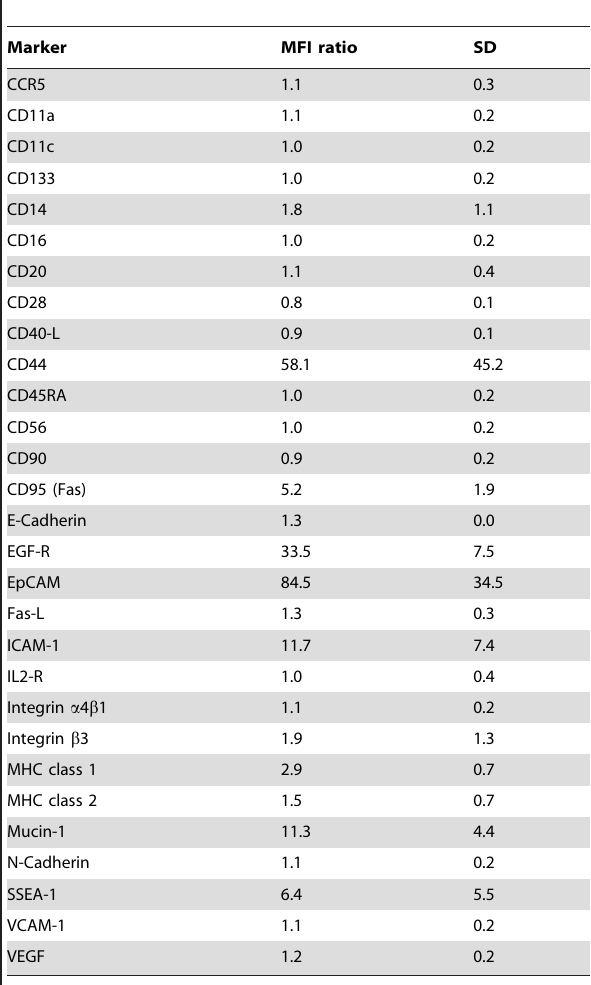
Table 2. The indicated cell surface markers were measured in three independent experiments with specific antibodies using flow